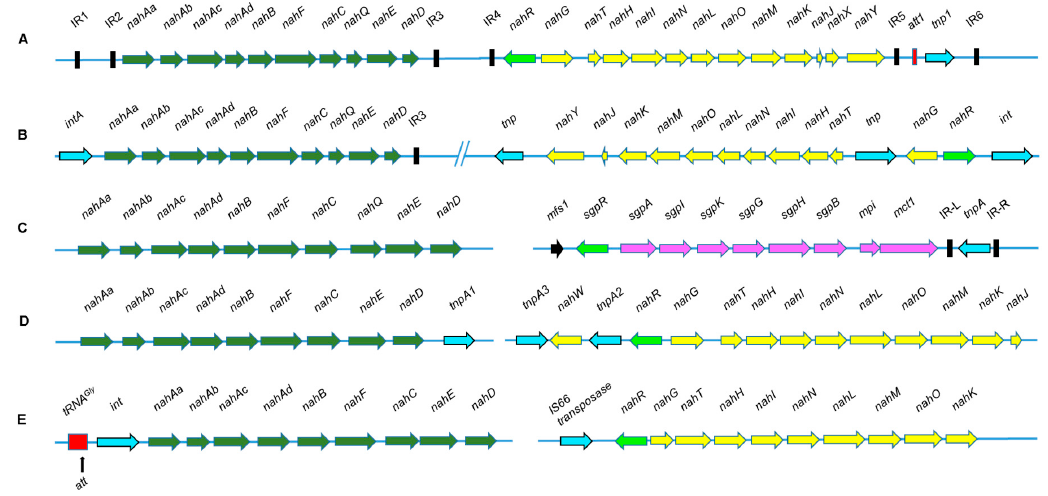
Figure 3. The diversity observed with respect to location, transcription and arrangement of genes involved in naphthalene degradation from: ( A ) Pseudomonas putida G7 as Tn 4655 transposon on plasmid NAH7 flanked by IR1 and IR6; ( B ) Pseudomonas putida strain NCIB9816-4 on conjugative plasmid pDTG1; ( C ) Pseudomonas putida AK5 on conjugative plasmid pAK5 via gentisate pathway; ( D ) Pseudomonas stutzeri AN10 on chromosome; ( E ) Pseudomonas putida CSV86 on ICE showing tRNA Gly andintegrasewhiletheotherendisstillnotknown. Arrowindicatesthedirectionoftranscription. Genes responsible for upper pathway, ‘ nah’ operon (naphthalene to salicylic acid metabolism) are depicted in green; lower pathway, ‘ sal’ operon (salicylic acid to central carbon metabolites via catechol) are depicted in yellow; while those in pink are responsible for salicylate metabolism via gentisic acid, ‘ sgp / gen’ operon. Genes depicted in cyan arrows indicates transposase or integrase, black boxes depict IR elements, while red box indicates tRNA gene with ‘ att ’ site, light green arrow represents the regulators of the operons and the black arrow represents the putative integral membrane transport protein. Figure is not to the scale. Genes and proteins encoded are: nahAa , 2Fe-2S iron-sulfur cluster binding domain-containing protein, reductase; nahAb , non-heme iron oxygenase ferredoxin subunit; nahAc, naphthalene 1,2-dioxygenase; nahAd , naphthalene 1,2-dioxygenase subunit beta; nahB , cis- naphthalene dihydrodiol